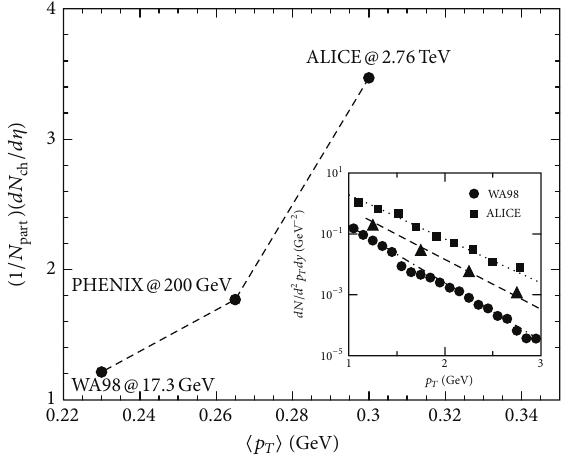
Figure 9: The variation of ⟨𝑝 𝑇 ⟩ with the increase in multiplicity for different collision